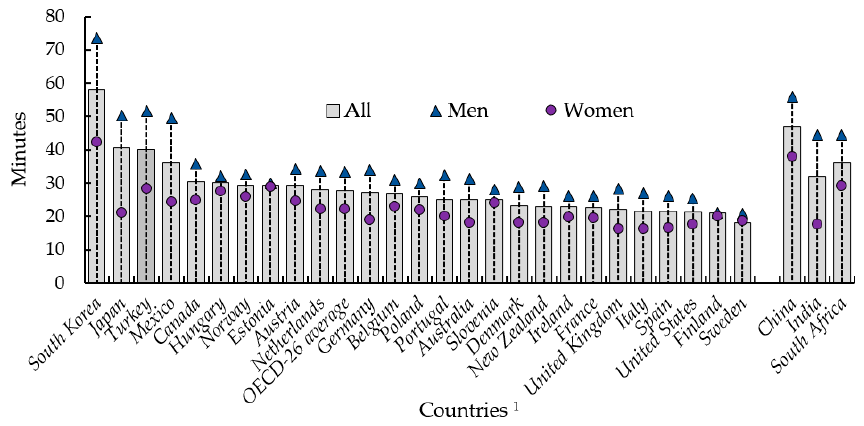
Figure 1. Average daily commuting time in OECD countries and China, India, and South Africa.